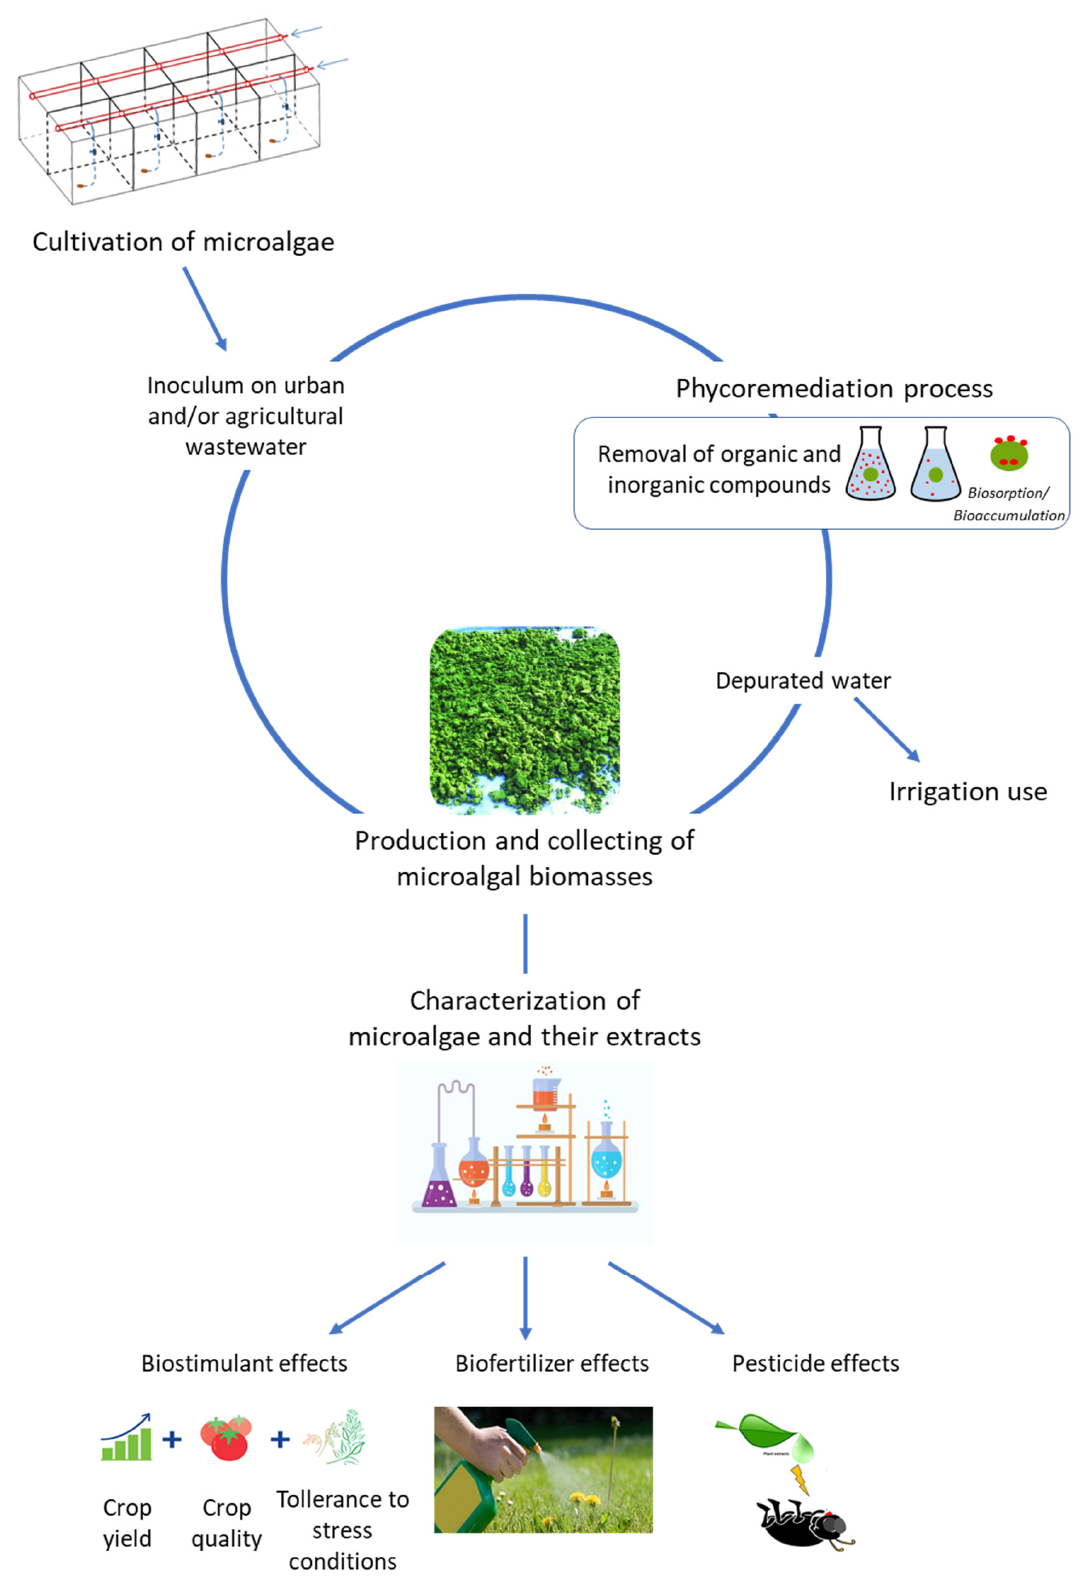
Figure 4. Ideal multipurpose applications of microalgae used for waste water treatment.